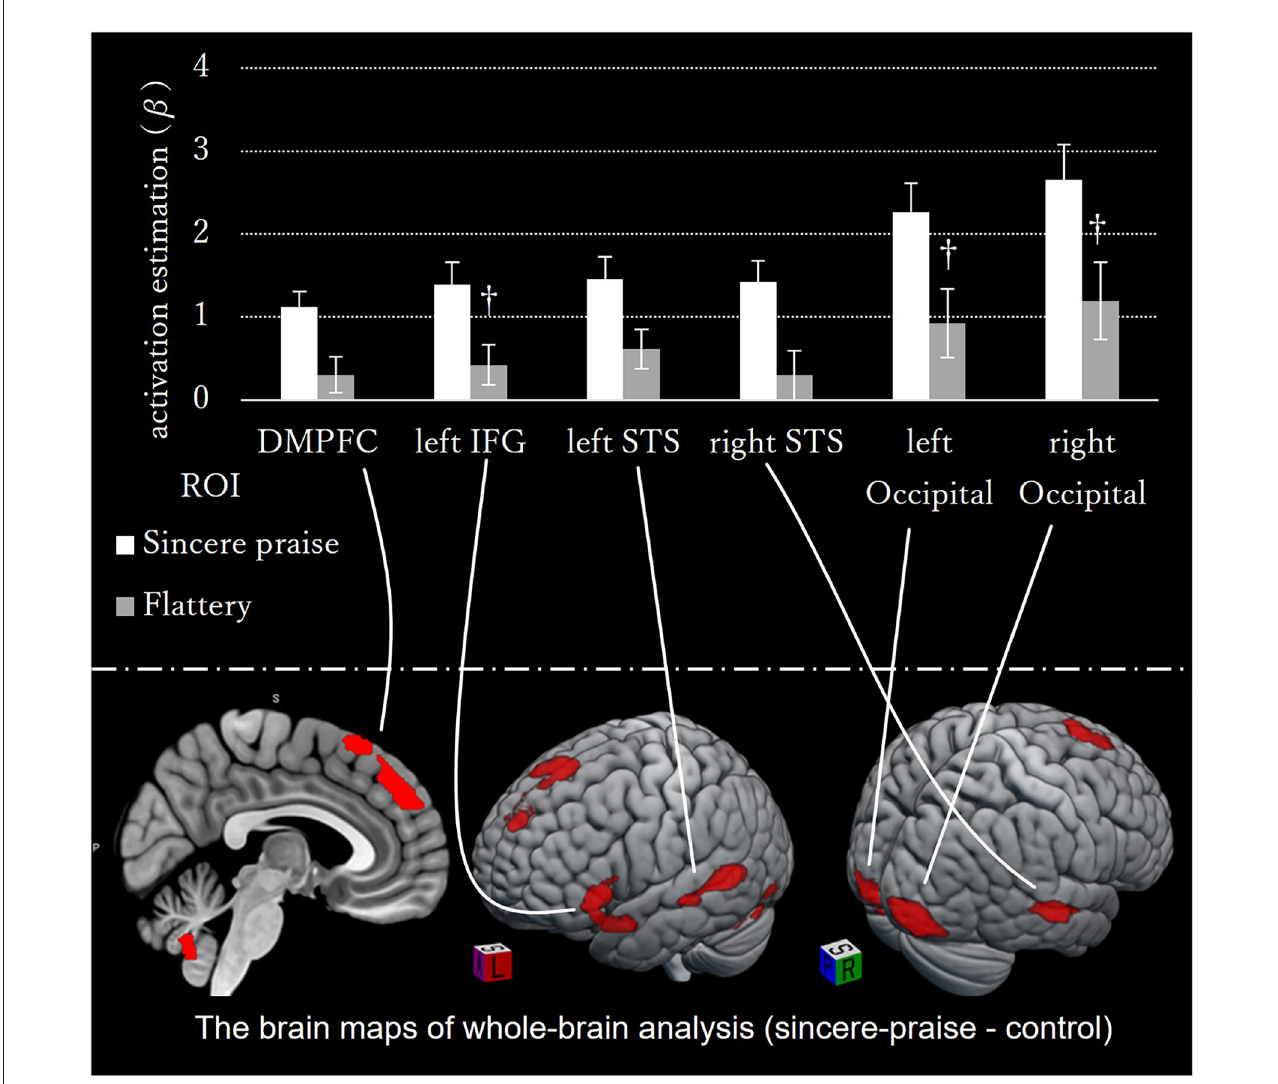
FIGURE3 Whole-brain activation during sincere praise compared to the control condition (speed-non-distinctive contrast). The brain maps on the bottom panel of whole-brain analysis comparing the sincere praise and control conditions (speed-non-distinctive contrast). Bar graph of the brain activity in ROIs in the sincere praise and flattery compared to the control conditions ( † : Bonferroni-uncorrected p -value < 0.05). Activation of the dorsal medial prefrontal cortex (DMPFC), left inferior frontal gyrus, and right superior temporal sulcus occurred only in response to sincere praise. Activity in DMPFC, left IFG, left STS, and right STS in the Flattery condition is insignificant in response to flattery. Brains were mapped onto the MNI template brain using MRIcroGL